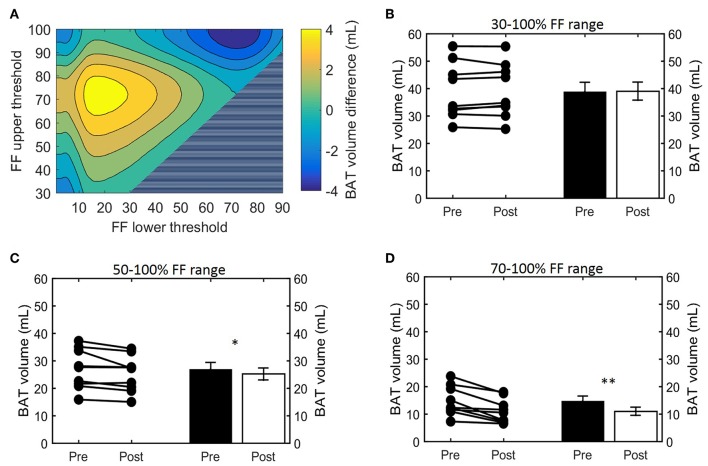
Effect of FF thresholds on estimated BAT volume differences. Heatmap of the effect of different FF segmentation thresholds on estimated BAT volume differences after cooling. The color (second y-axis) depicts the estimated BAT volume difference for each lower (x-axis) and upper left (y-axis) threshold. The largest decrease in estimated BAT volume is present with a lower threshold of 72% and no upper threshold. The triangle in the lower right corner indicates invalid FF threshold options, as we implemented a minimum FF threshold of 30%. (A) Cold-induced volume changes analyzed using the paired sample t-test (*p < 0.05, **p < 0.01) at different threshold ranges: 30–100% (B), 50–100% (C), and 70–100% (D). Data is represented as mean ± SEM for all participants (n = 9).